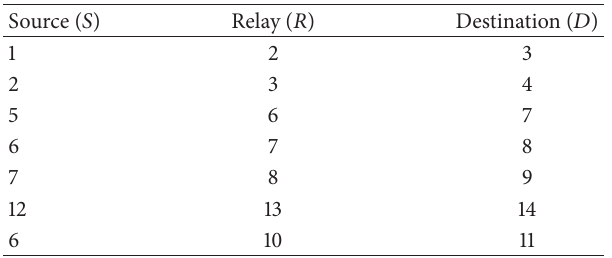
Table 2: Measurement scenario for the investigation of DOA and DOD at